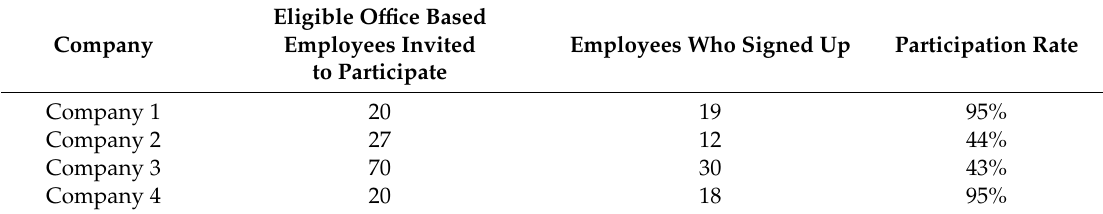
Table 4. Individual company participation rates.